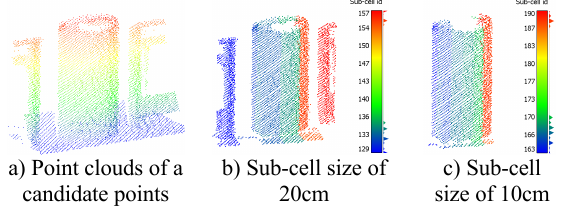
Figure 12 . Impact of sub-cell size on extracted points of public garbage